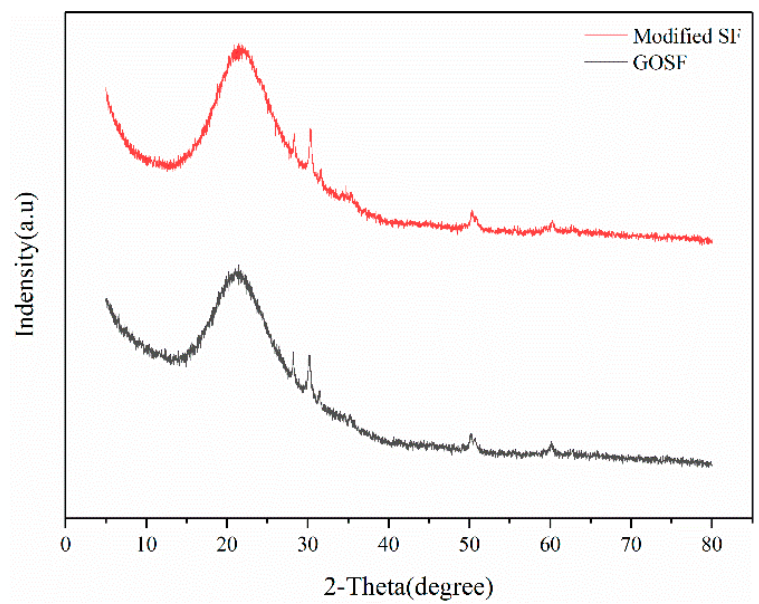
Figure 4. XRD patterns of SF and